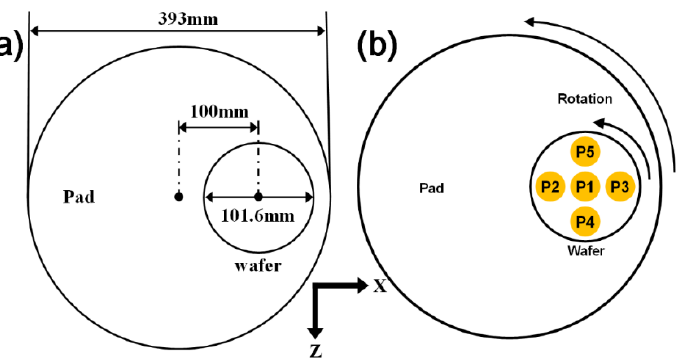
Figure 5. ( a ) Parts of the mesh models for simulation, and ( b ) mesh size distribution of R0 and R32 pad.